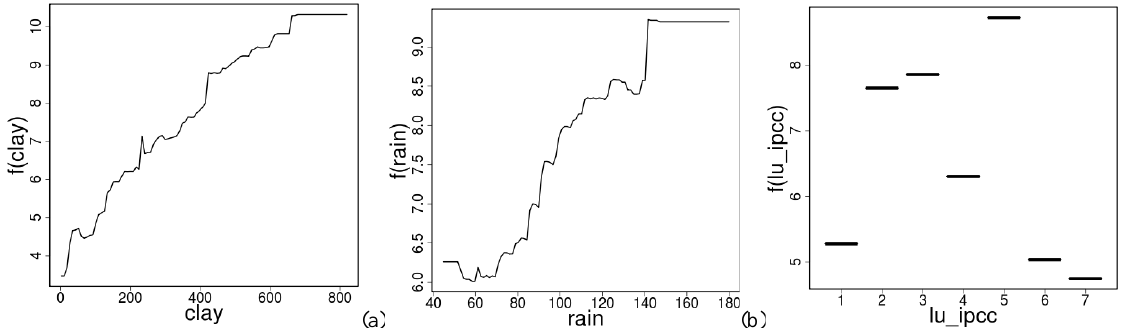
Fig. 6. Effect of the three most important variables in the Extra model (i.e. (a) clay , (b) rain and (c) lu ipcc ). The lu ipcc variable is coded using the adapted IPCC classification: croplands (1), permanent grasslands (2), woodlands (3) orchards, shrubby perennial crops (4), wetlands (5), others (6), vineyards